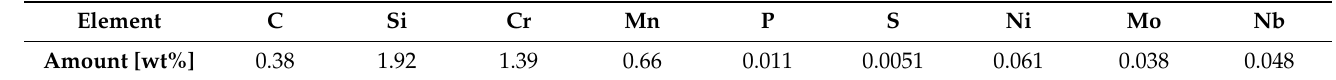
Table 1. Chemical composition of the studied 42SiCr steel.